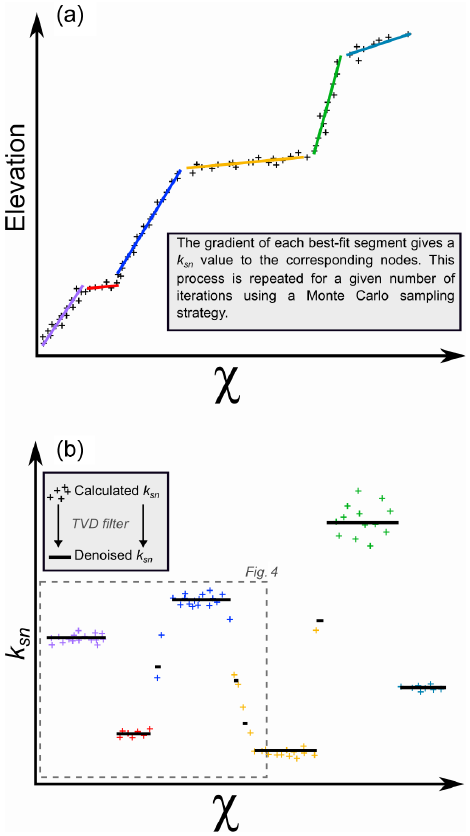
Figure 3. Extraction of normalised channel steepness ( k sn ) from a river profile. (a) Example of best-fit segmentation (Mudd et al., 2014) where + symbols are individual data points and the coloured lines are the segments. (b) The associated plot of k sn plotted as a function of χ coordinate. The segmentation output results in some noise due to iterative sampling of the channel network (+ symbols). A total variation denoising filter (Condat, 2013) is then applied on the signal to extract the main variations in k sn